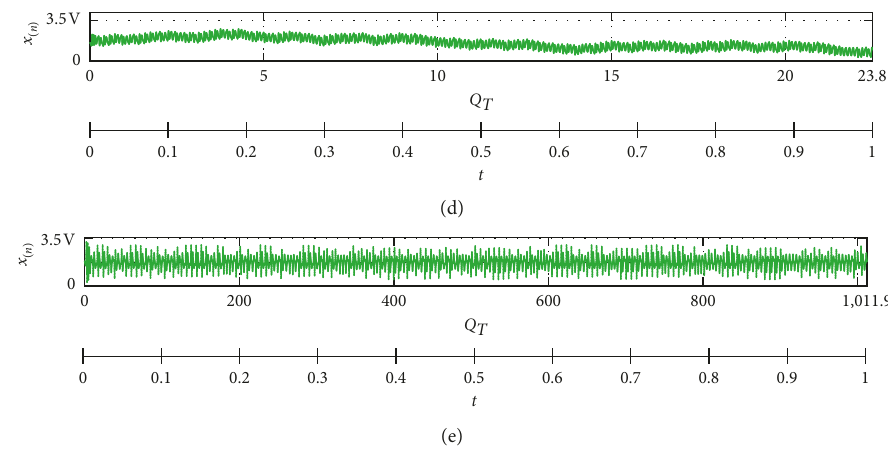
Figure 16: Time series of the five CSs of Lorenz, R¨ossler, Chen, Liu and Chen, and MACM in their DVs by using the Euler NA to compare the performance of version 2 dsPIC of ES expressed Q T for t � 1 second: (a) x ( n ) of Lorenz, (b) x ( n ) of R¨ossler, (c) x ( n ) of Chen, (d) x ( n ) of Liu and Chen, and (e) x ( n ) of